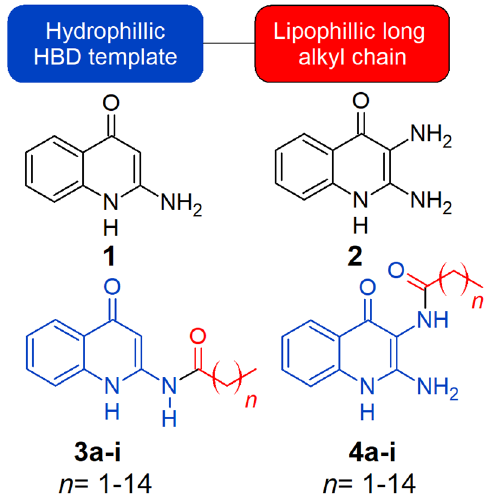
Figure 2. General structural requirements for biofilm inhibitors based on AHL and quinolone derivatives proposed as QSIs.